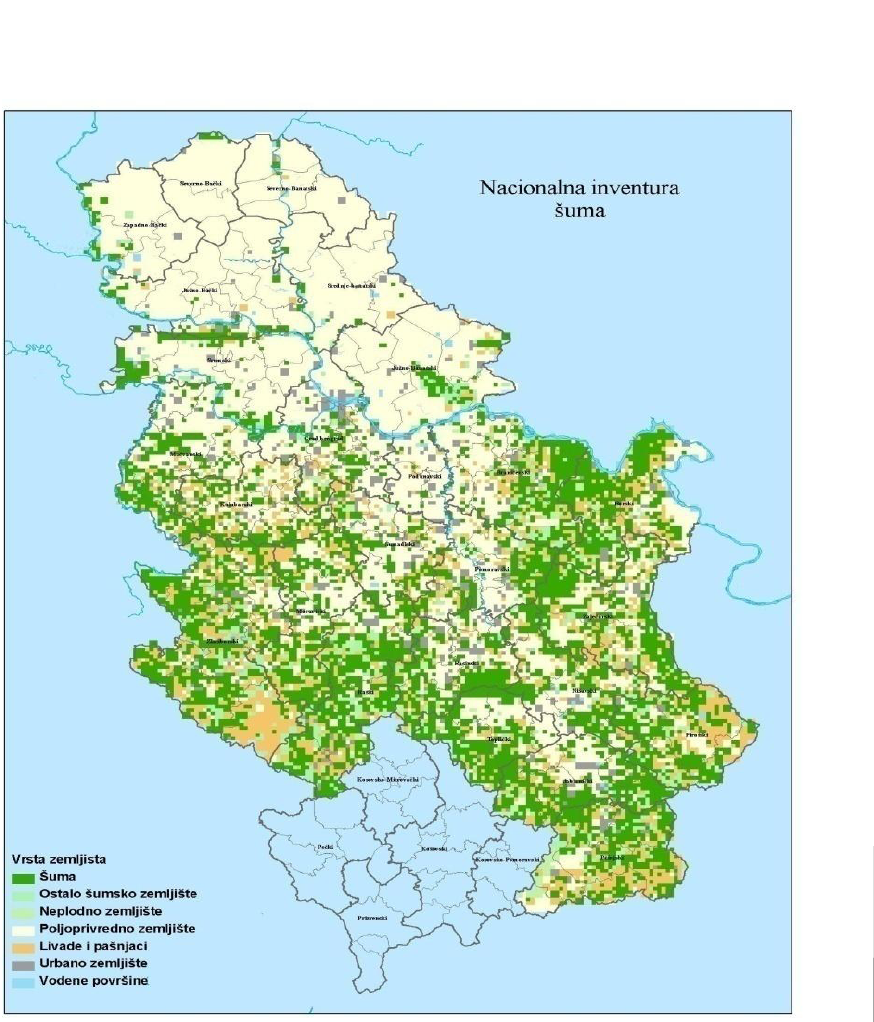
Figure 1 – Forest area of the Republic of